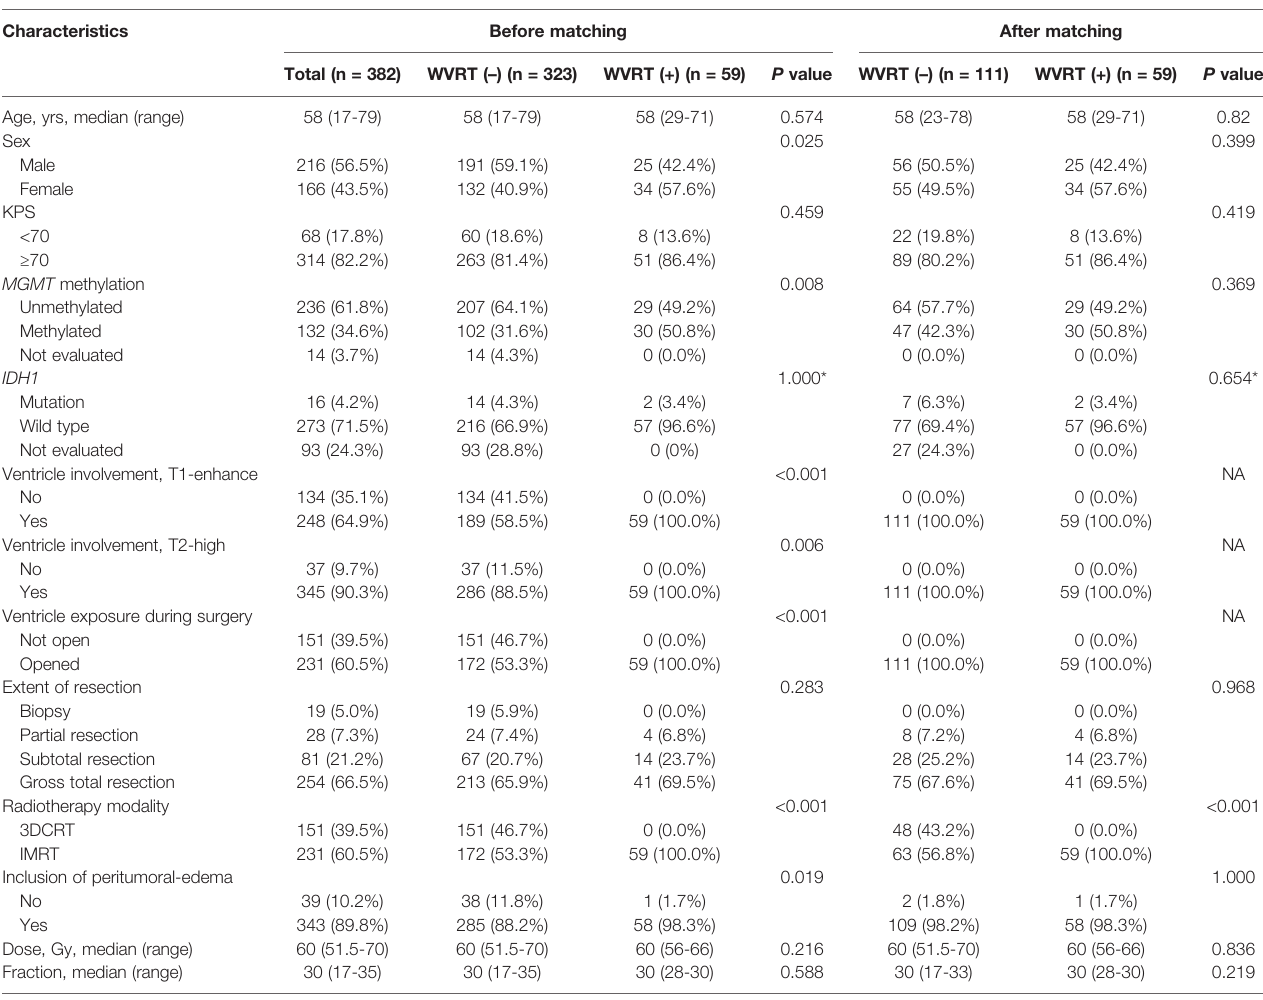
TABLE 1 | Patient characteristics in the pre- and post-matching cohorts. Characteristics Before